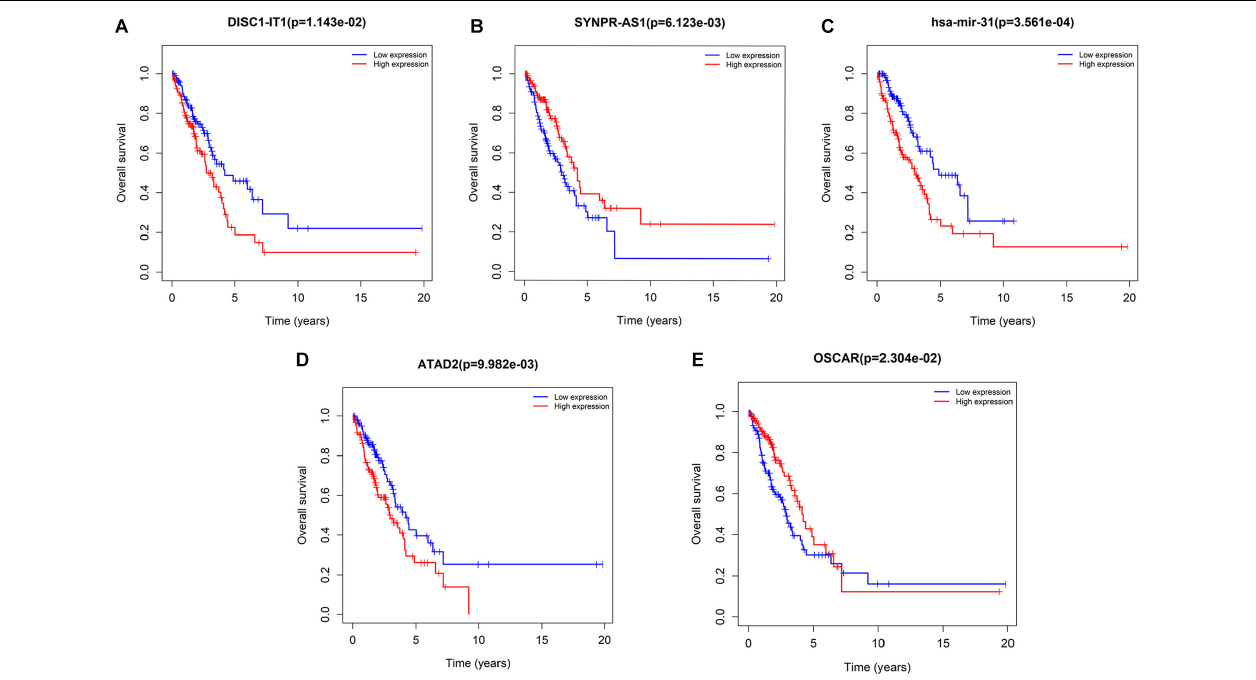
FIGURE 7 | Kaplan–Meier curve analysis of DERNAs for the overall survival in LUAD patients. Five representative DERNAs, including DElnRNAs: (A) DISC1-IT1 (B) SYNPR-AS1; DEmiRNAs: (C) hsa-mir-31; and DEmRNAs: (D) ATAD2 (E) OSCAR ( p < 0.05). Horizontal axis: overall survival time, years; vertical axis: overall survival